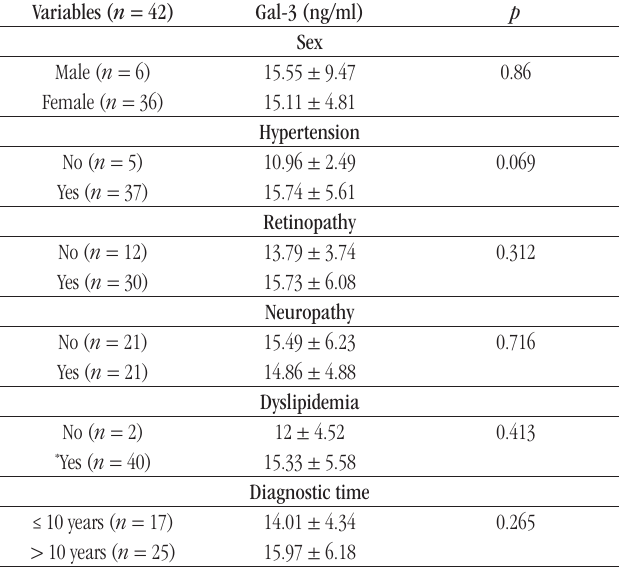
TABLE 3 – Gal-3 levels in relation to the descriptive variables in the T2DM with kidney disease